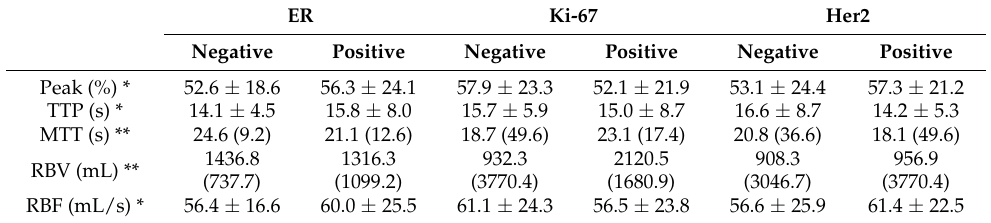
Table 3. Association between CEUS quantitative parameters and pathological prognostic factors.